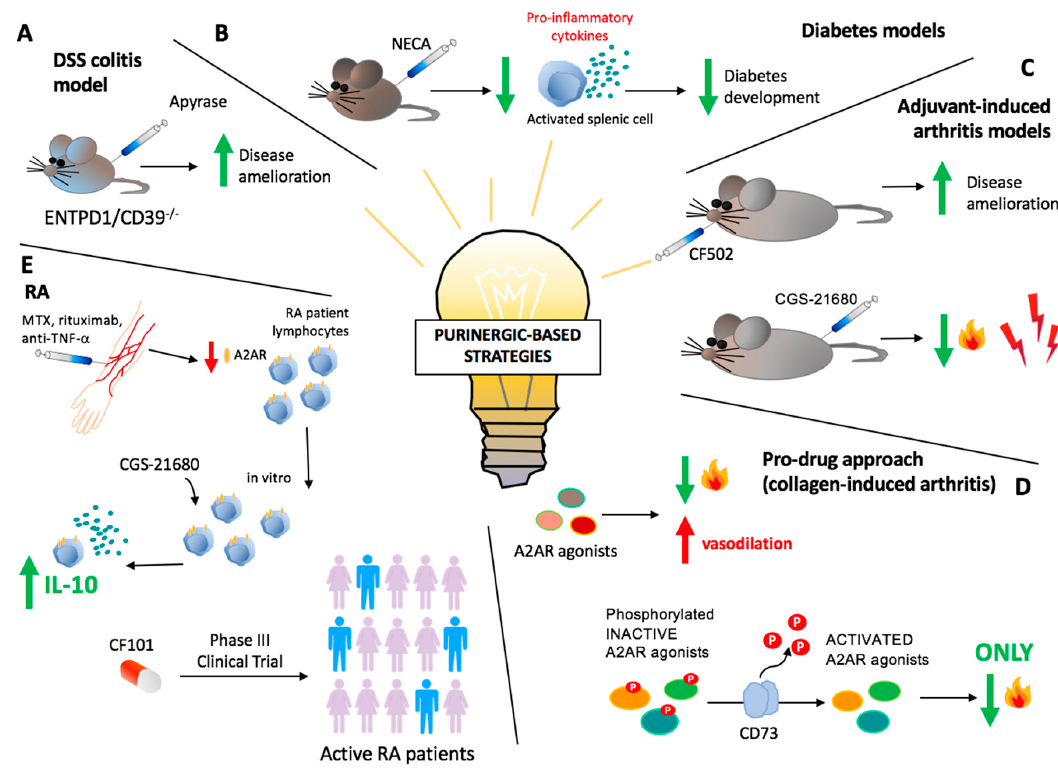
Figure 2. Purinergic-based therapeutic strategies. ( A ) Administration of exogenous apyrase strongly ameliorates dextran-sulfate-sodium (DSS) colitis in ENTPD1/CD39 − / − mice. ( B ) In experimental